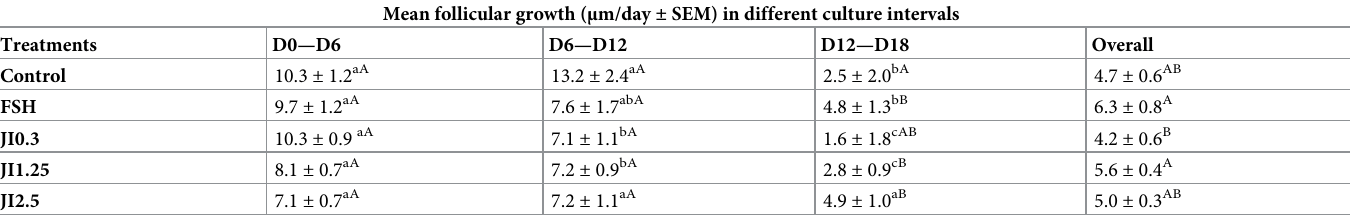
Table 2. Mean ( ± SEM) daily growth of morphologically intact secondary follicles at different time point (D0, D6, D12, D18) in MEM + (Control), FSH or in J . insu- laris 0.3, 1.25 or 2.5 mg/mL (JI0.3, JI1.25 or JI2.5 respectively).